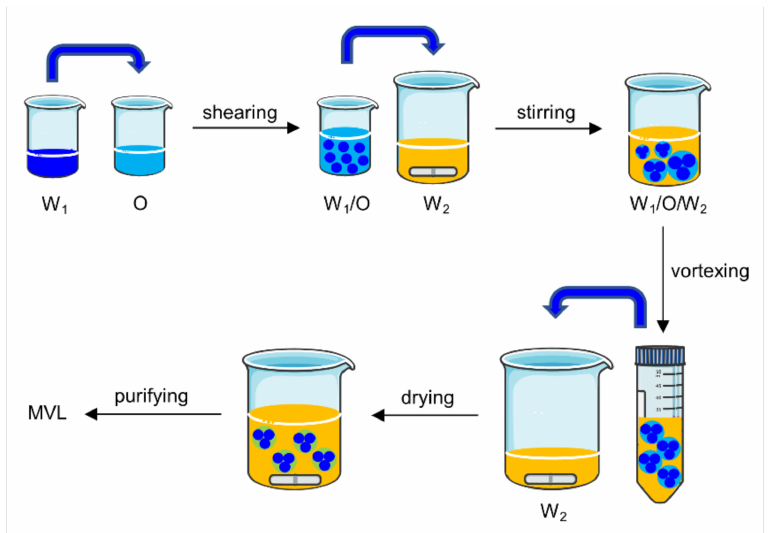
Figure 3. Schematic representation of MVL preparation. W 1 , inter water phase; O, chloroform solution; W 2 , external water